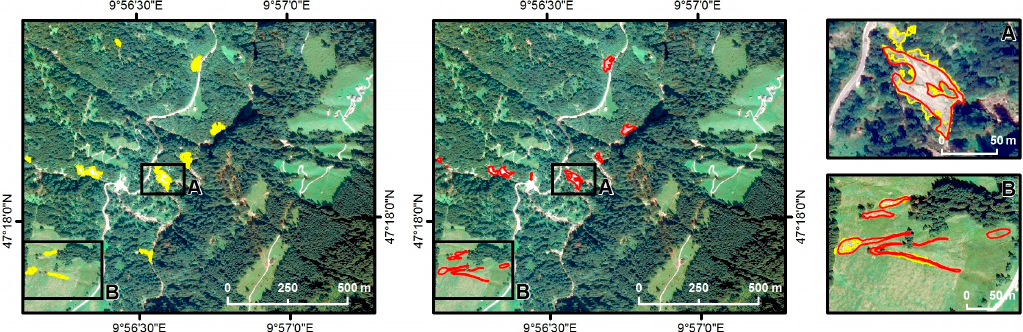
Figure 5. Semi-automatically mapped landslides using the object-based image analysis (OBIA) approach (in yellow; left ) and manually mapped landslides (in red; middle ) for study area IV based on the WorldView-3 image. Two subsets demonstrating the variation of the mapping results for selected landslides are shown on the right . The black rectangles (A, B) indicate the location of the subsets.